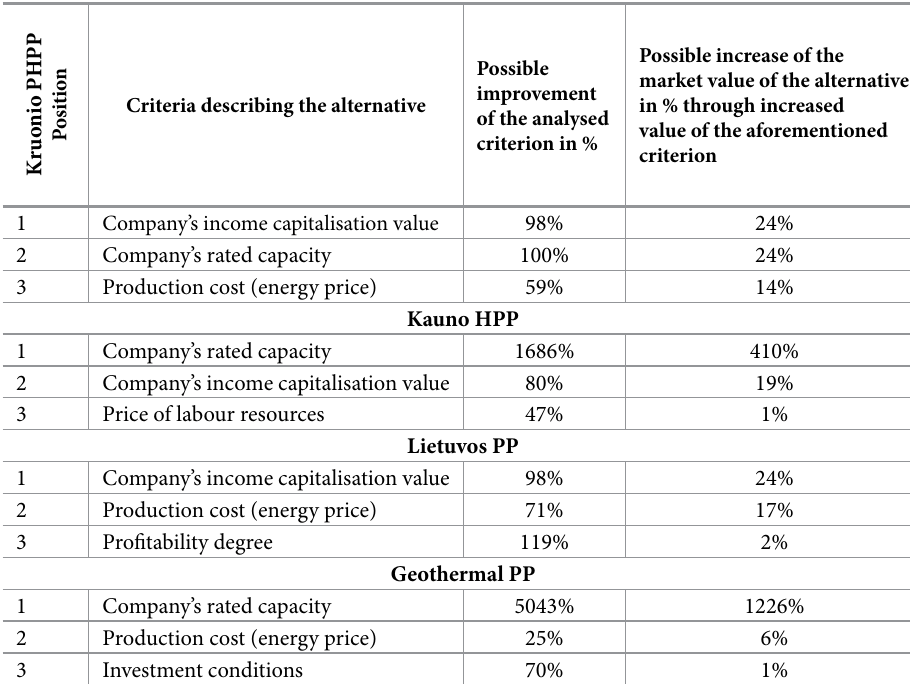
table 12. TOP 3 object criteria that have the greatest influence on the ranking pp h p i criteria describing the alternative o i t n i o s o p u K r